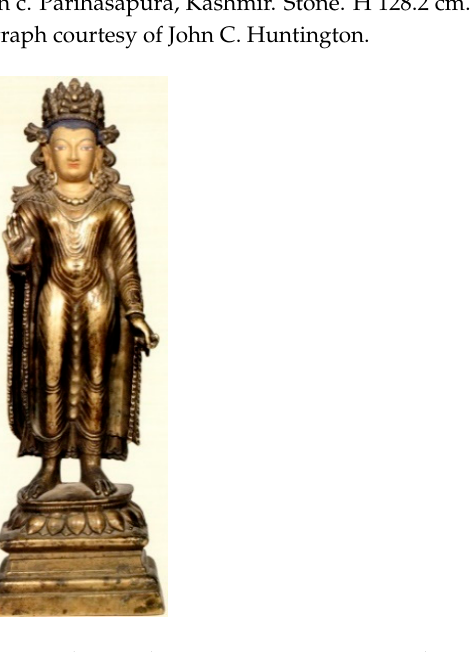
Figure 8. Buddha wearing a crown. Eighth to ninth c. Kashmir. Brass. H 35 cm. Po to la Collection: Li